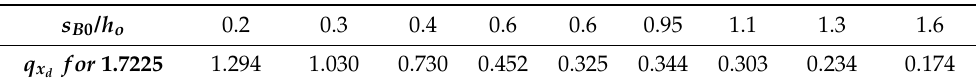
Table 3. Empiric parameter q Xd for 1.7225 [23].